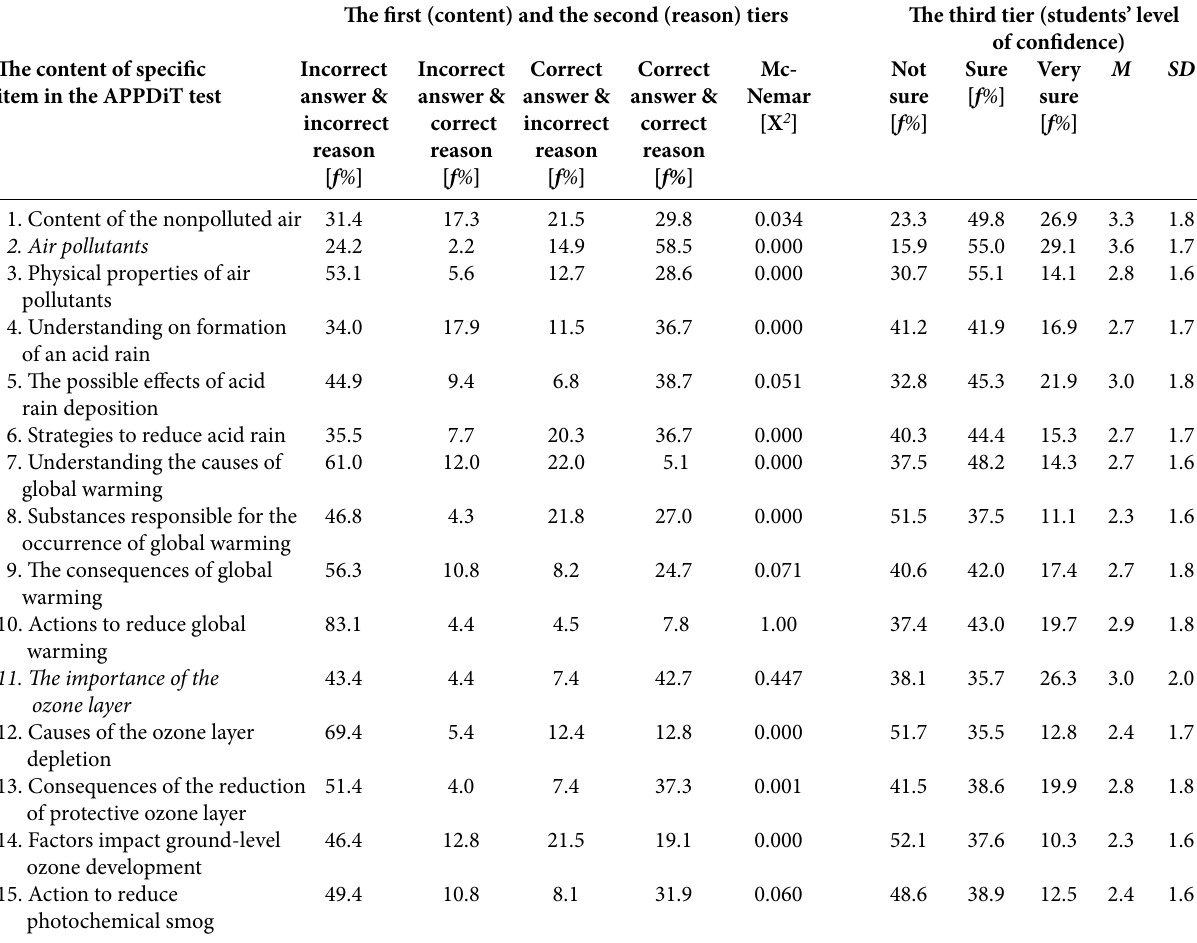
Table 1. The success of students’ responses for the APPDiT diagnostic test. The first (content) and the second (reason)